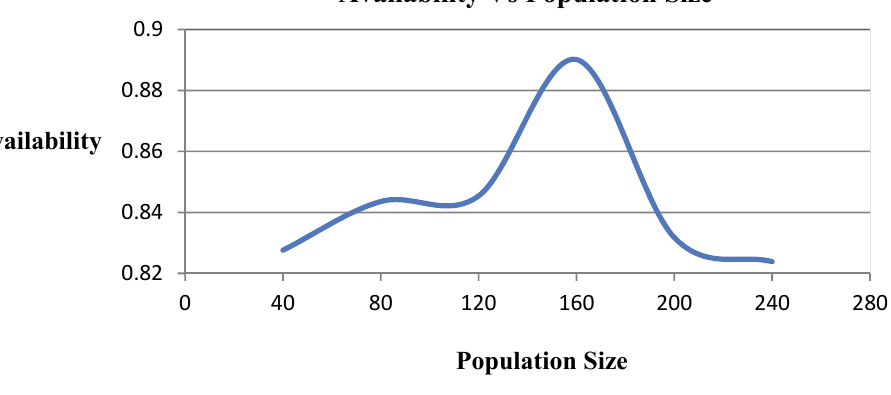
Fig. 4. Effect of Population Size on Fabric Finishing System Availability using TLBO